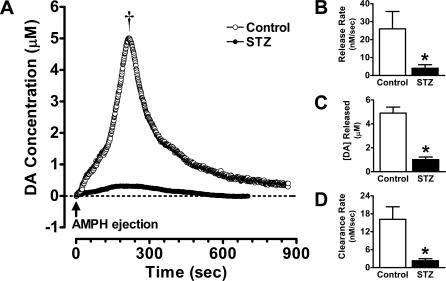
Depletion of Insulin Severely Blunts the Ability of AMPH to Release DA(A) Shown in the figure are integrated DA oxidation traces from a representative control rat and a STZ-treated rat, obtained using HSCA in the striatum. AMPH (400 μM/125 nl) was microinjected into the striatum (arrow), and extracellular DA levels were measured.(B–D) Summary data for HSCA, *p < 0.05, Students t-test for independent samples (n = 6). The slope of the rising portion of the DA signal—indicating the rate of AMPH-induced DA release—was decreased in STZ-treated rats compared to control (B), as was the amount of released DA (C). The slope of the descending phase of the DA signal, corresponding to the rate of clearance of AMPH-evoked DA, was also diminished in hypoinsulinemic rats (D).